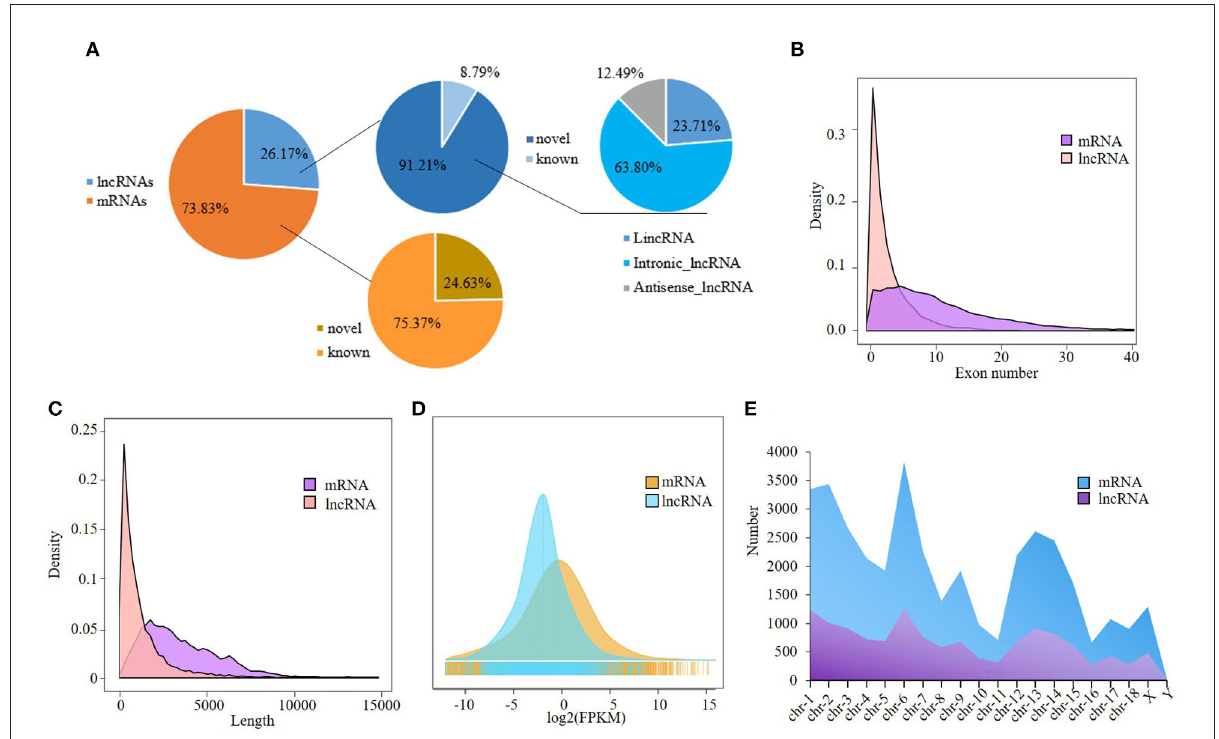
FIGURE1 Analysis of RNA-seq data. (A) Classification of lncRNAs and mRNAs; (B,C) Transcript length and exon number distribution of the lncRNAs and mRNAs; (D) Distribution of the lncRNAs and mRNAs in chromosomes; (E) Expression level distribution of the lncRNAs and